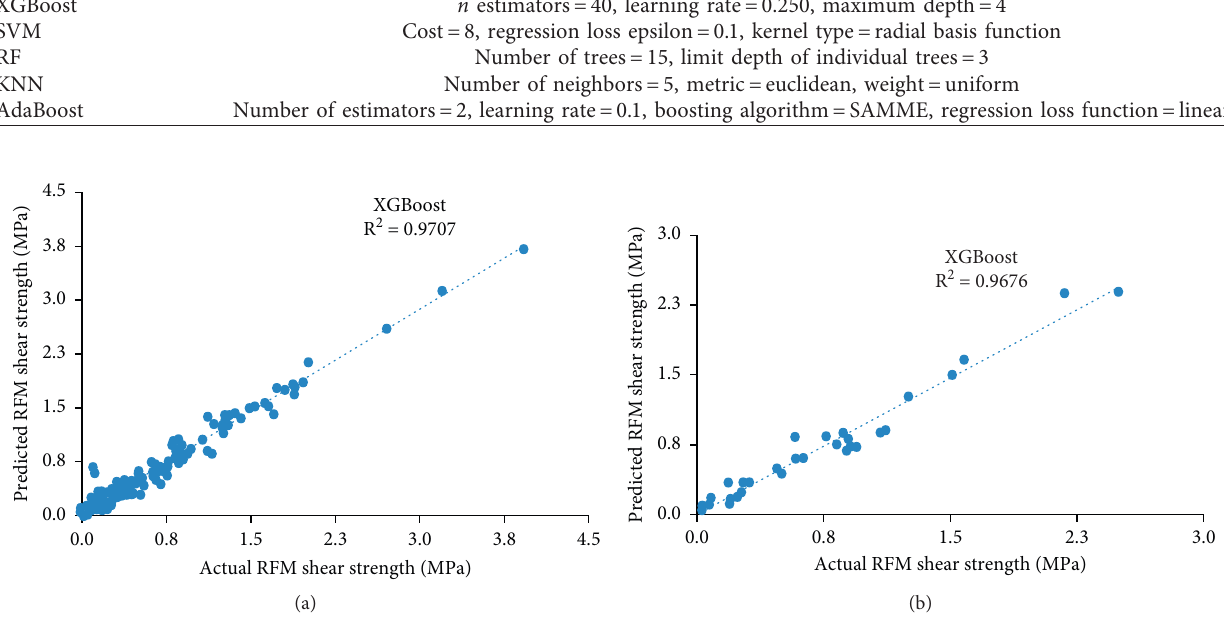
Table 2: Parameter configuration. Algorithm Parameter optimization